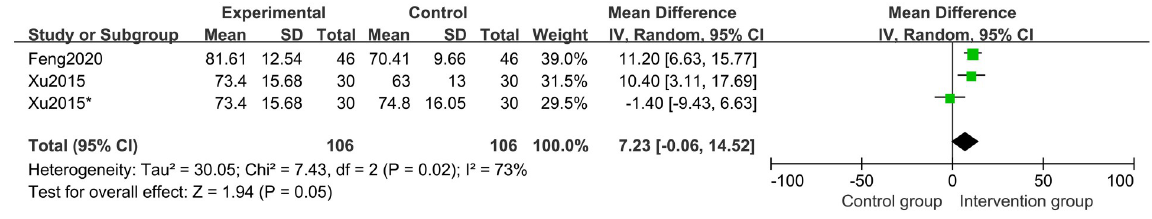
Fig 15. Forest plot of osteocalcin.